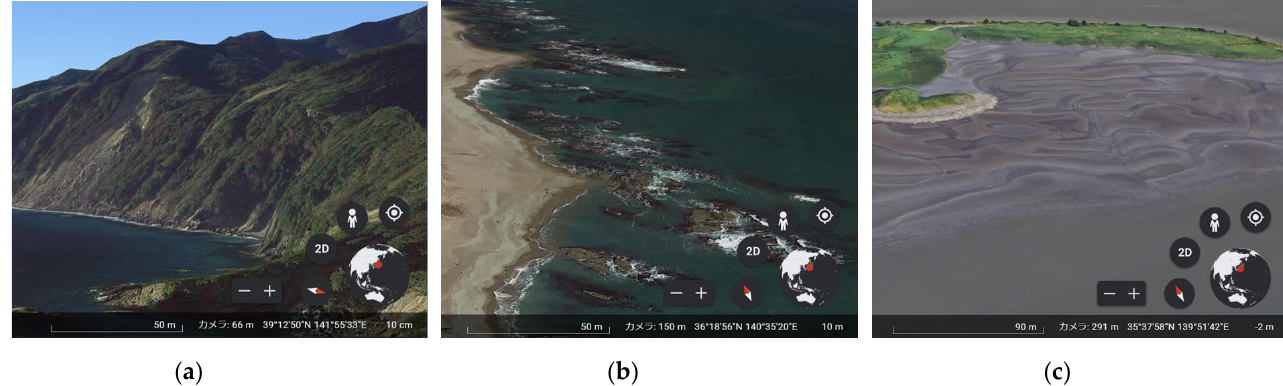
Figure 3. Topographical/land conditions: ( a ) cliffs, ( b ) rocky beaches, and ( c ) wetlands and mudflats. Source of photo: Google Earth Pro.